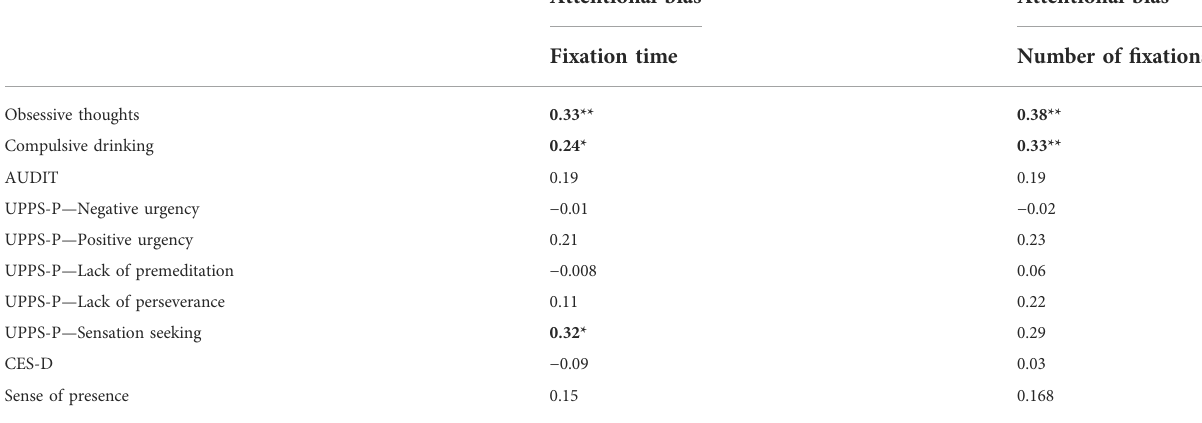
TABLE 6 Kendall ’ s and Pearson ’ s correlations between attentional bias scores and alcohol craving, alcohol consumption, impulsivity, depressive symptomatology and sense of